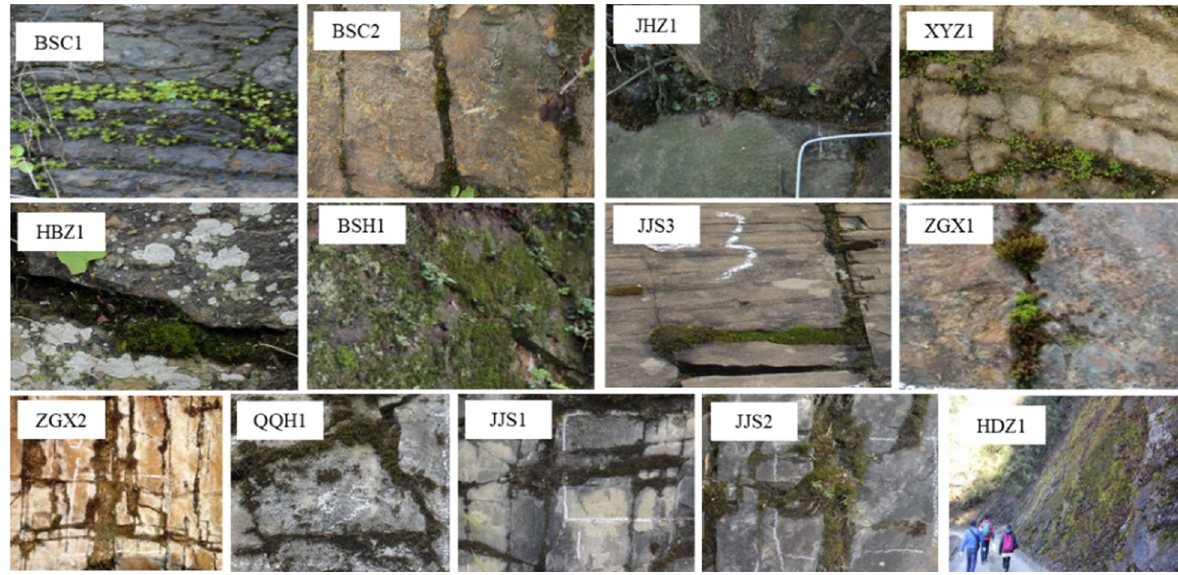
Fig. 2 BSCs development and crevices at selected sampling sites on 13 rock cut